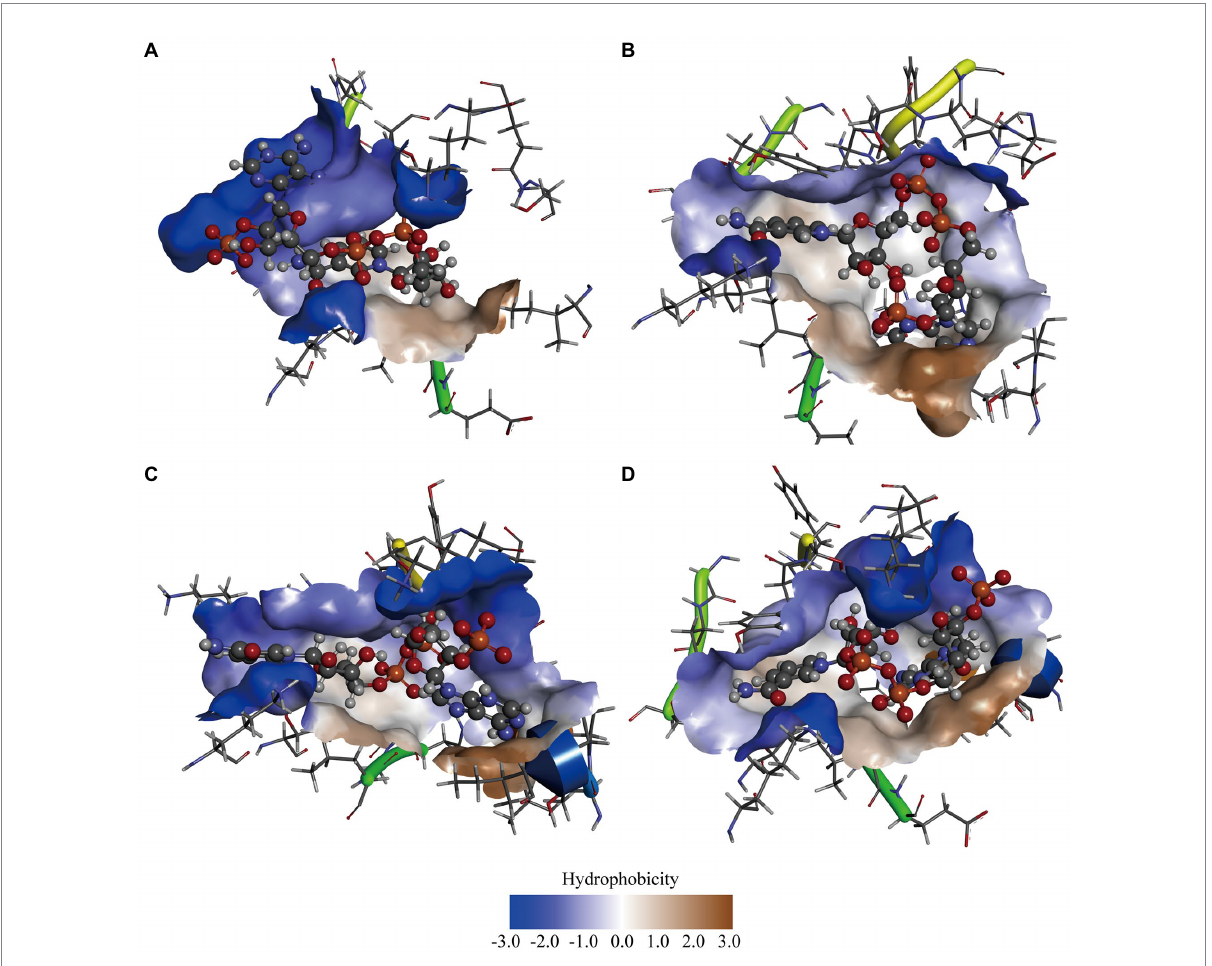
FIGURE 3 Computer-assisted hydrophobicity analysis of GDH mutants. (A) GDH-NADP + complex; (B) P45A-NADP + complex; (C) N46E-NADP + complex; (D) F155Y-NADP + complex. The shade of color indicates the strength of hydrophobicity.